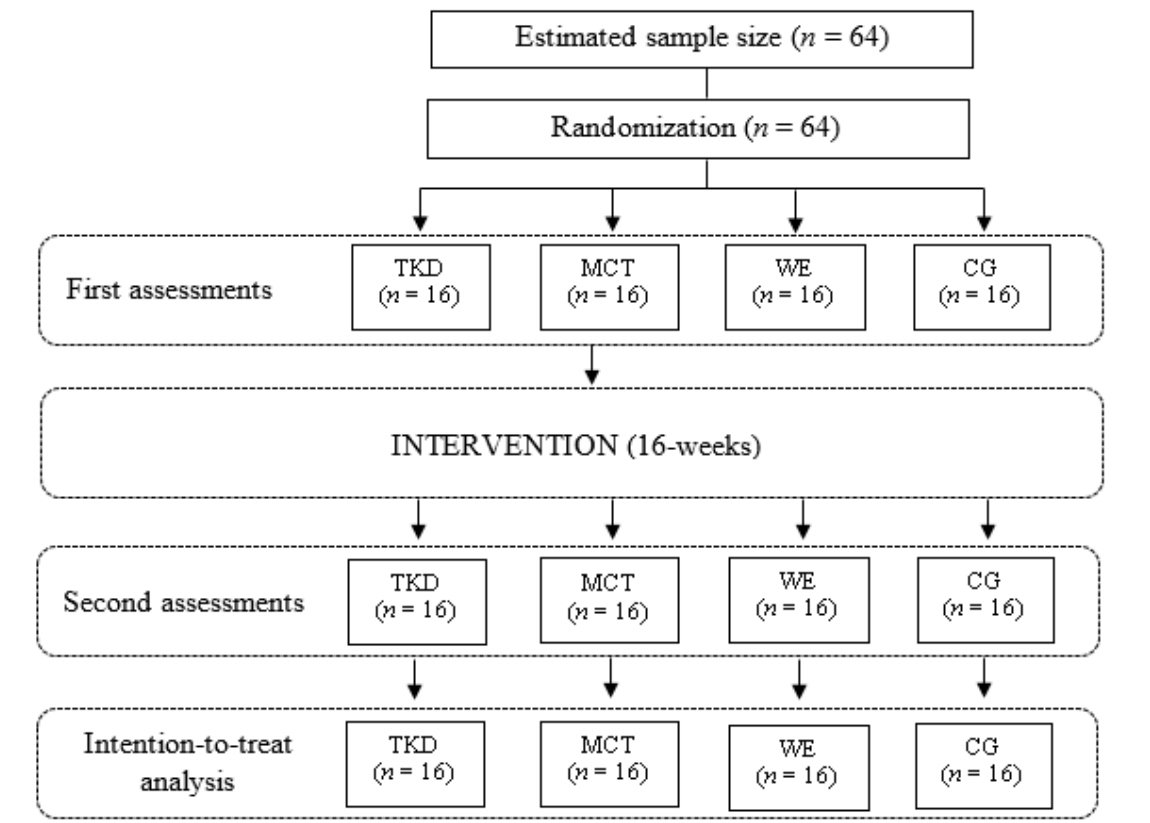
Figure 1. Study flowchart. Legends: CG: Control group (no intervention). MCT: multi-component training. n : number of participants. TKD: Adapted taekwondo. WE: Walking exercise.